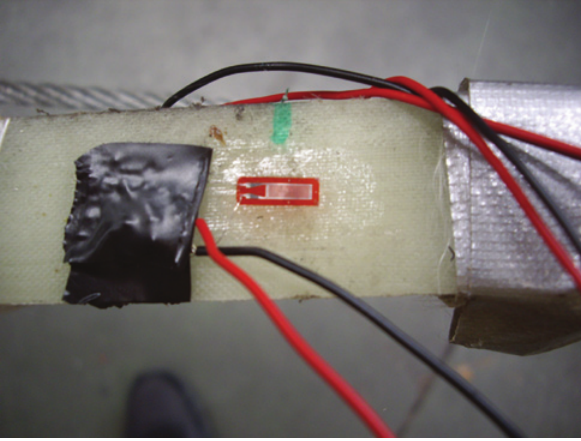
Figure 14 Gauge installed in the sandwich test